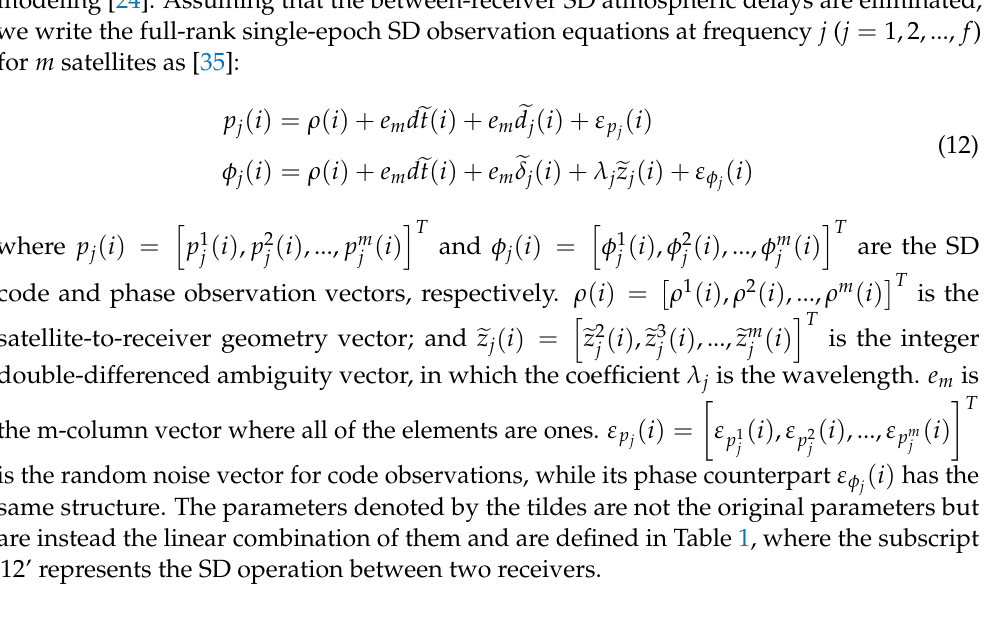
Table 1. Estimable parameters of between-receiver single-differenced